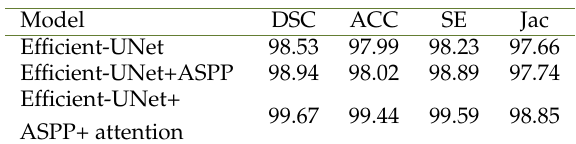
Table 5. Comparison of different